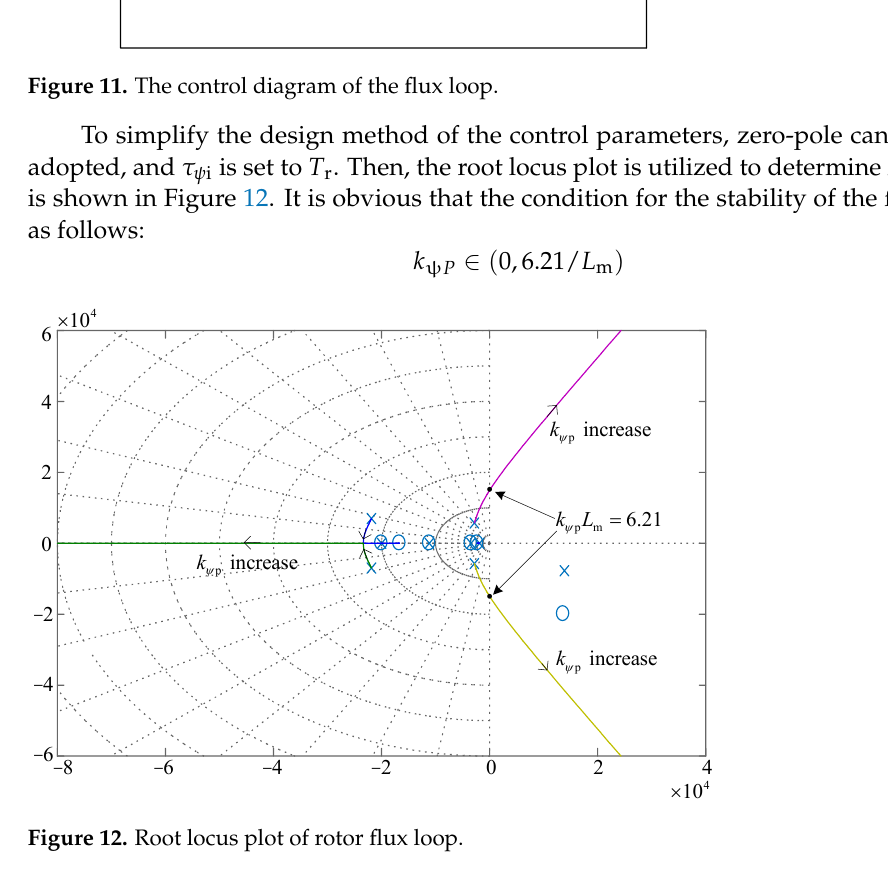
Figure 12. Root locus plot of rotor flux loop.